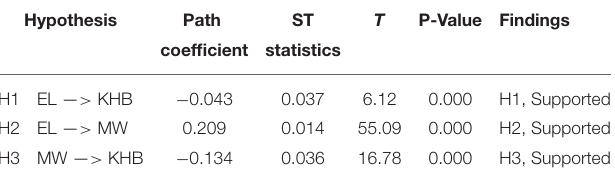
TABLE 6 | Hypothesis